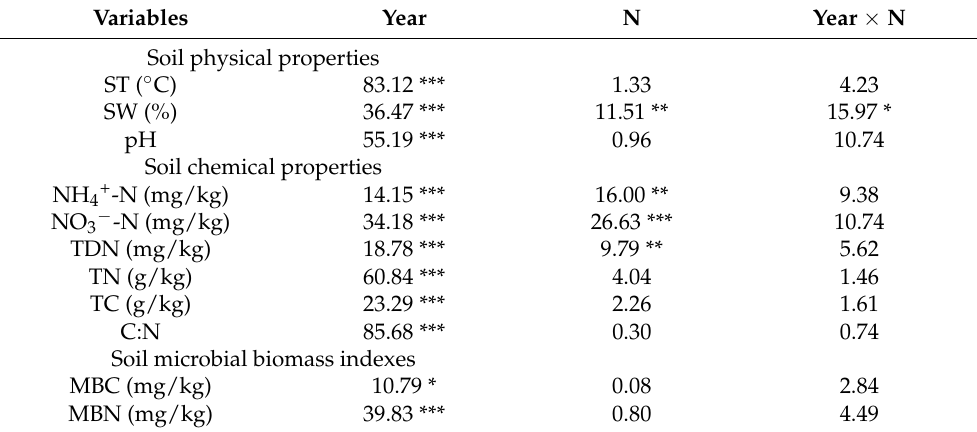
Table 3. Summary (F-values) of the generalized linear mixed-effect model used to evaluate the effects of year, nitrogen application (N), and their interactive effect on soil property and microbial biomass during the study period.